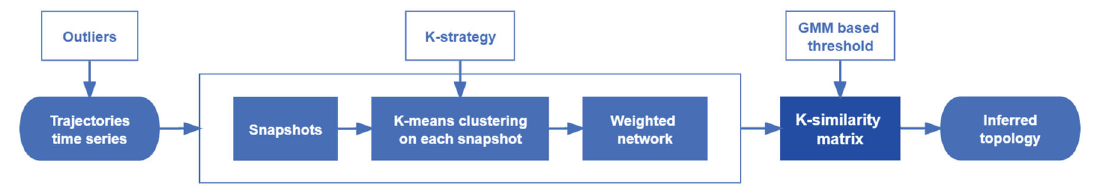
Fig. 1 Overview of the method